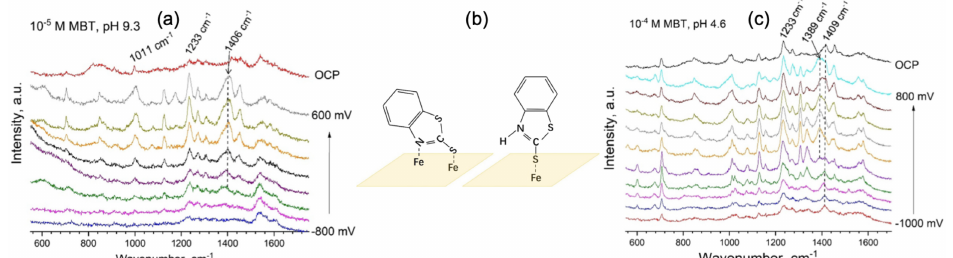
Figure 3. ( a ) SHINERS spectra of a MBT solution (0.01 mM) recorded at pH 9.3 for different potentials. The black dotted line indicates the Raman peak at 1406 cm − 1 . ( b ) Potential configurations of the MBT adsorption on pyrite. ( c ) SHINERS spectra of a MBT solution (0.1 mM) recorded at pH 4.6 for different potentials. The black dotted lines indicate the Raman peaks at 1389 and 1409 cm − 1 . All the figures are reprinted from [93], Copyright 2020, with permission from Elsevier.